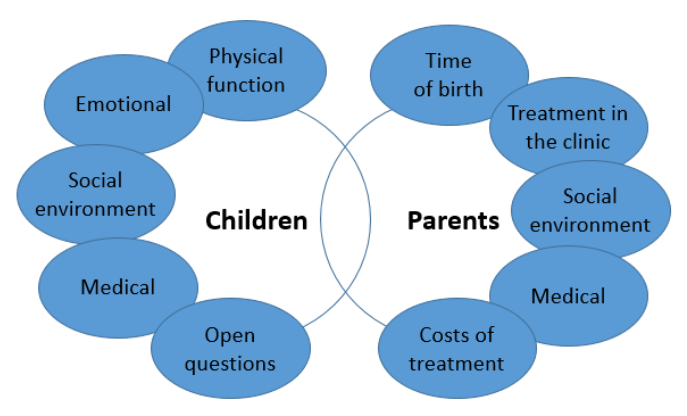
Figure 1. Dimensions of the newly developed questionnaire for children and